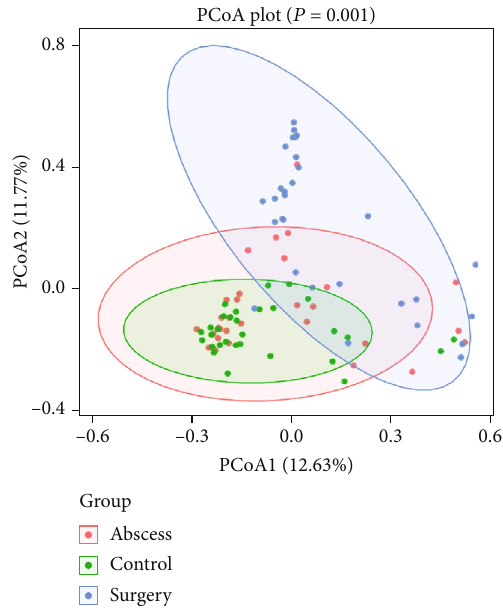
Figure 4: Principal coordinate analysis (PCoA) of the gut microbiota based on Bray-Curtis